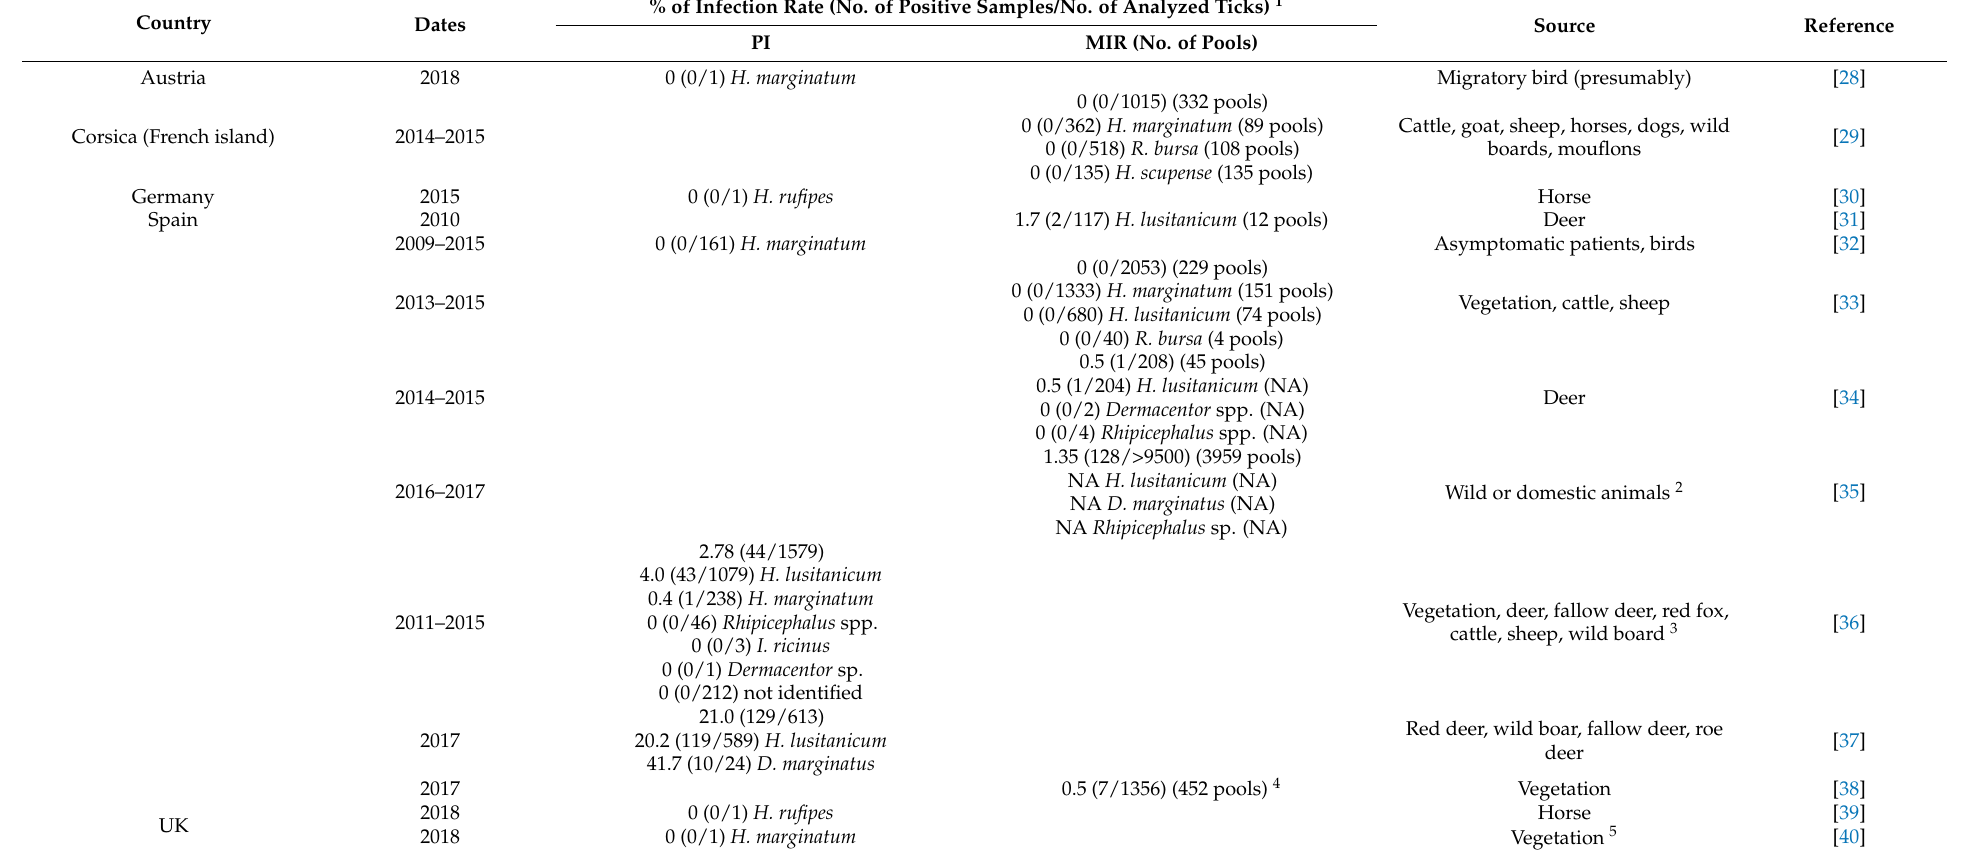
Table 1. Prevalence of Crimean-Congo hemorrhagic fever virus (CCHFV) in